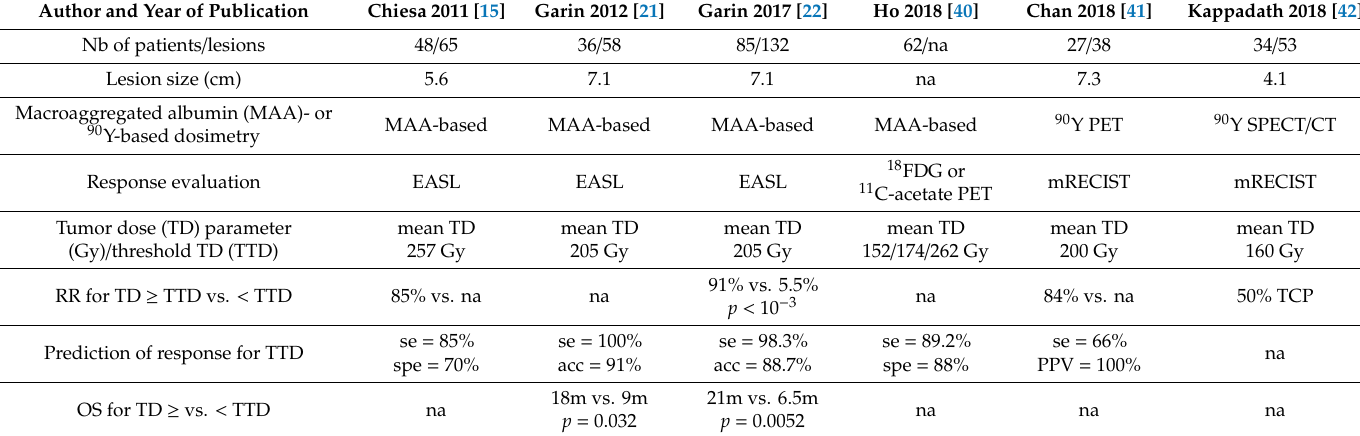
Table 1. Studies with tumor dose outcome correlation in hepatocellular carcinoma (HCC) with glass micropsheres.